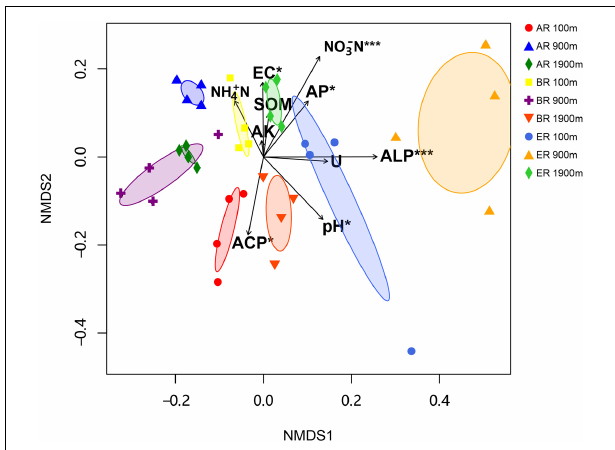
FIGURE 3 | Non-metric multidimensional scaling (NMDS) of fungal community (stress = 0.249). Significant variables NO 3 - –N (NO 3 - –N; R 2 = 0.430, P < 0.001), alkaline phosphatase (ALP; R 2 = 0.419, P < 0.001), acid phosphatase (ACP; R 2 = 0.204, P = 0.026), electrical conductivity (EC, R 2 = 0.180, P = 0.034) and pH ( R 2 = 0.242, P = 0.012) are fitted onto the NMDS graph based on the results of “envfit” function analysis. The arrows represent fitted vectors of edaphic variables with distribution significantly correlated with fungal community composition (* P < 0.05, *** P < 0.001). SOM, soil organic matter content; AK, available potassium; AP, available P; Urease, activity of soil